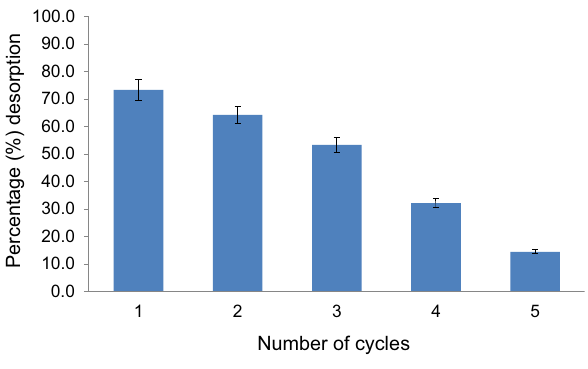
Fig. 3 Adsorption–desorption of Cr(VI) ions and reusability of adsor- bent using HCl as desorbing agent